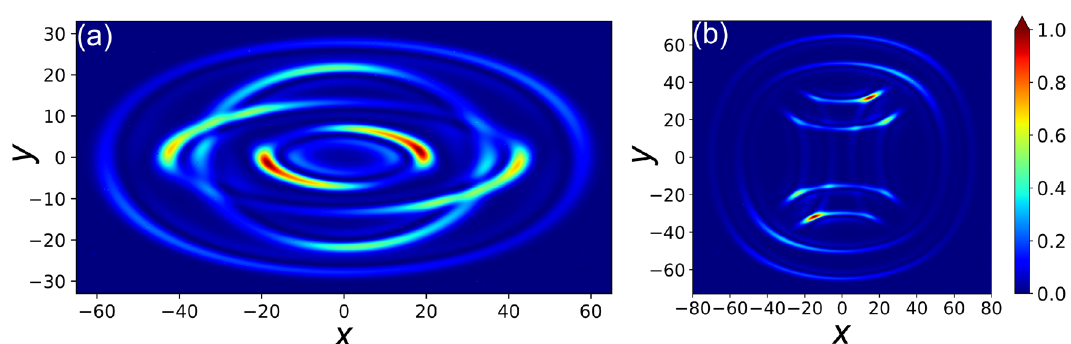
0 , Figure 4. Calculated non-circular CD patterns for a cascade of three mutually crossed crystals ( γ 1 = 12.0 , ρ 2 9.3 and ρ 3 7.3 . The magnification factors associated γ 2 π/ 2 , γ 3 π ) with CD strengths ρ 1 = = = = = 2.50 , M 1.25 , 4.30 , M to the k -space manipulations between each pair of BCs (see text) are: ( a ) M x 1 x 2 = y 1 = = 1.25 , M 2.50 , M 0.325 ; ( b ) M 0.325 , M 4.30 . Therefore the manipulation in ( b ) M y 2 x 1 = x 2 = y 1 = y 2 = = between the second and third BC is the same as the one in ( a ) between the first and second BC, and vice versa. The color scale gives the relative